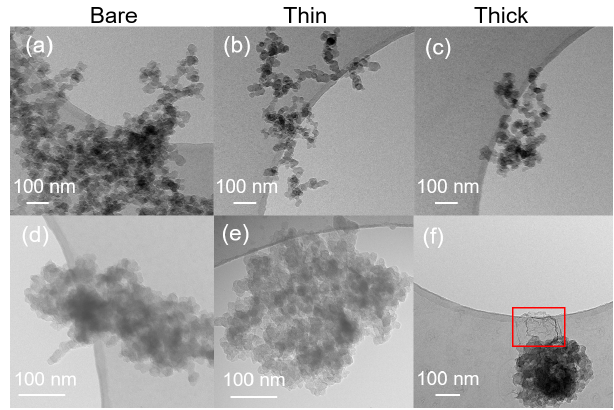
Figure 9. TEM images for 200nm size-selected bare and coated mCASTblack and FW200 soot particles. Scale bars are indicated in each image. (a) Bare mCASTblack, (b) mCASTblack with a thin coating (coating wt = 2.9%), (c) mCASTblack with a thick coat- ing (coating wt = 30.2%), (d) bare FW200, (e) FW200 with a thin coating (coating wt = 2.3%), and (f) FW200 with a thick coating (coating wt = 139.3%). Microscopes used: (a) – (c) and (f) TFS F30, (d) and (e) Hitachi